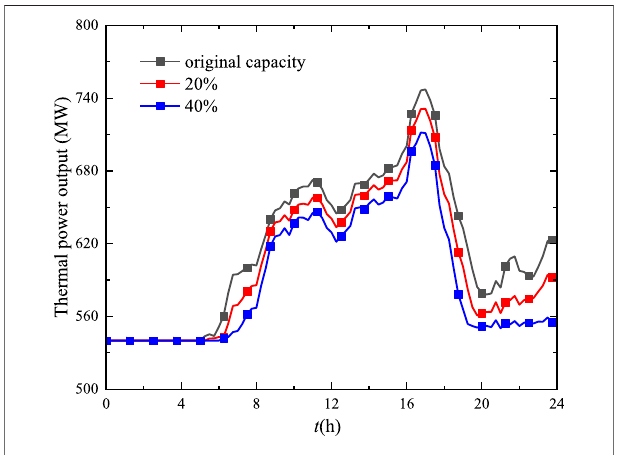
FIGURE10| Thermalpower generationunderdifferentnewwindpower installed capacities.